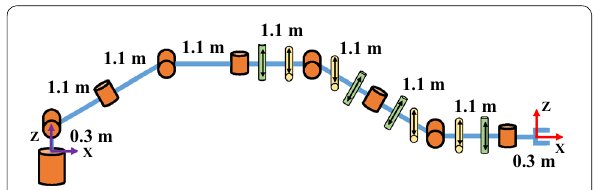
Fig. 7 The setup of the simulation robotic arm and flying